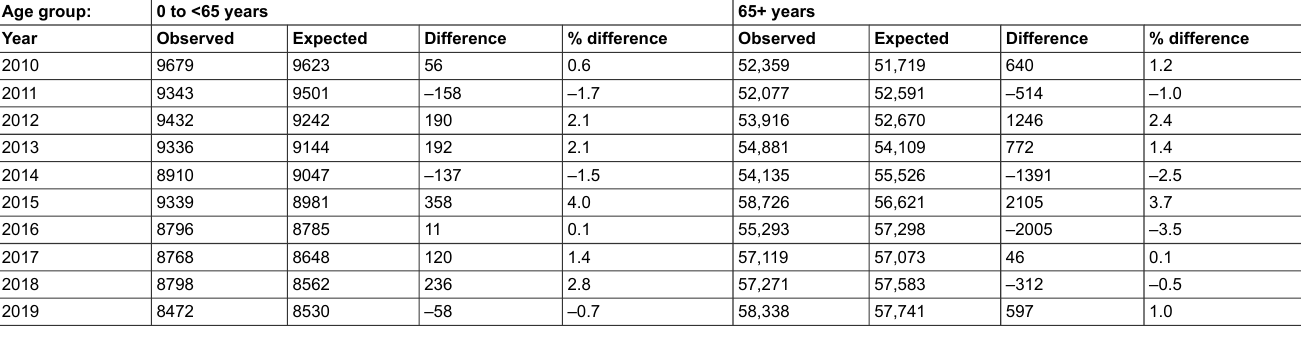
Table 1: Performance characteristics of the Swiss national mortality monitoring based on the proximity of the annually expected and the observed numbers of deaths in the period of 2010 to 2019. Age